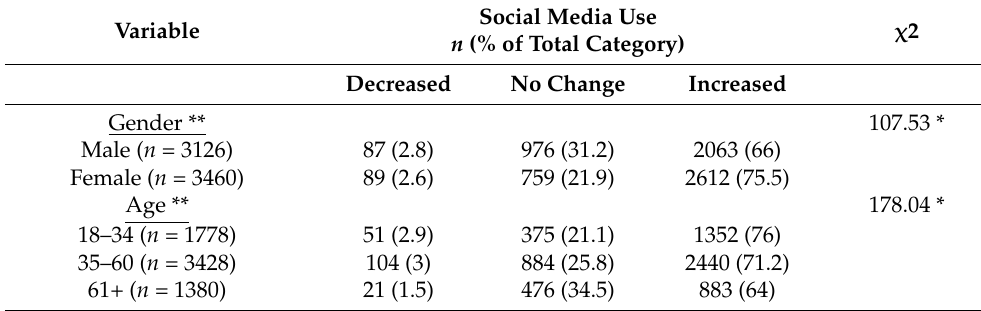
Table 5. Wave 1 associations between social media use and gender and age. Variable